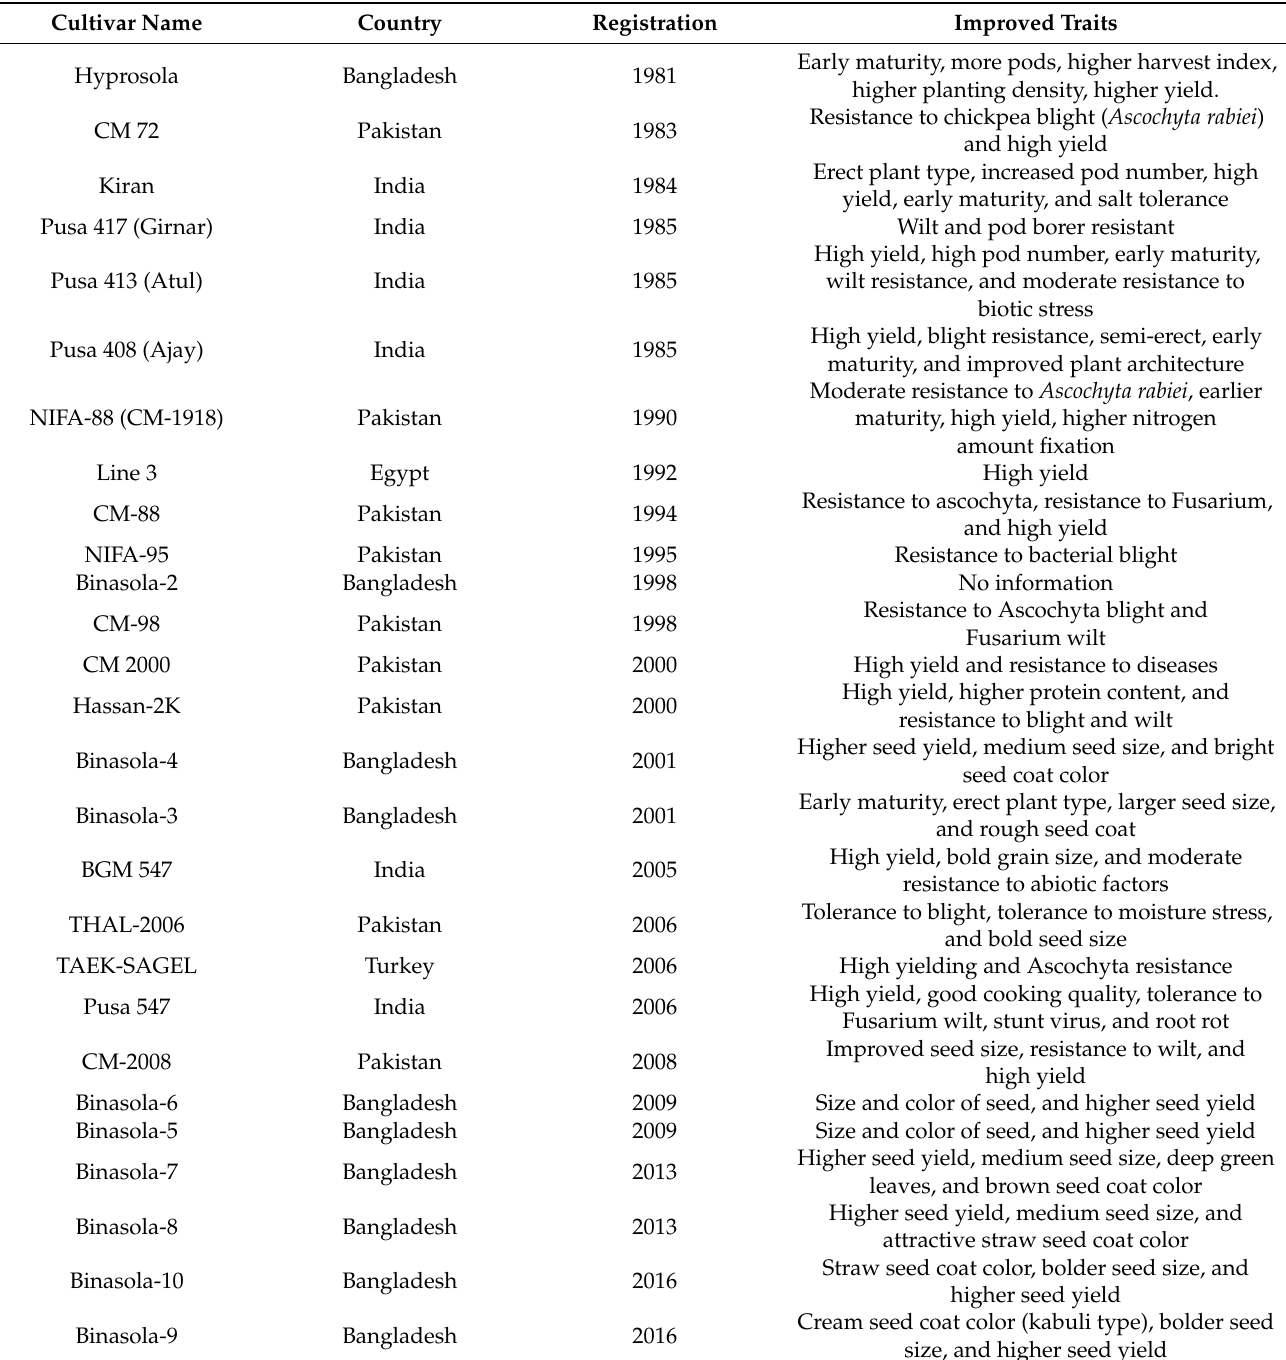
Table 2. Mutant cultivars of chickpea approved by the Joint FAO/IAEA Division of Nuclear Tech- niques in Food and